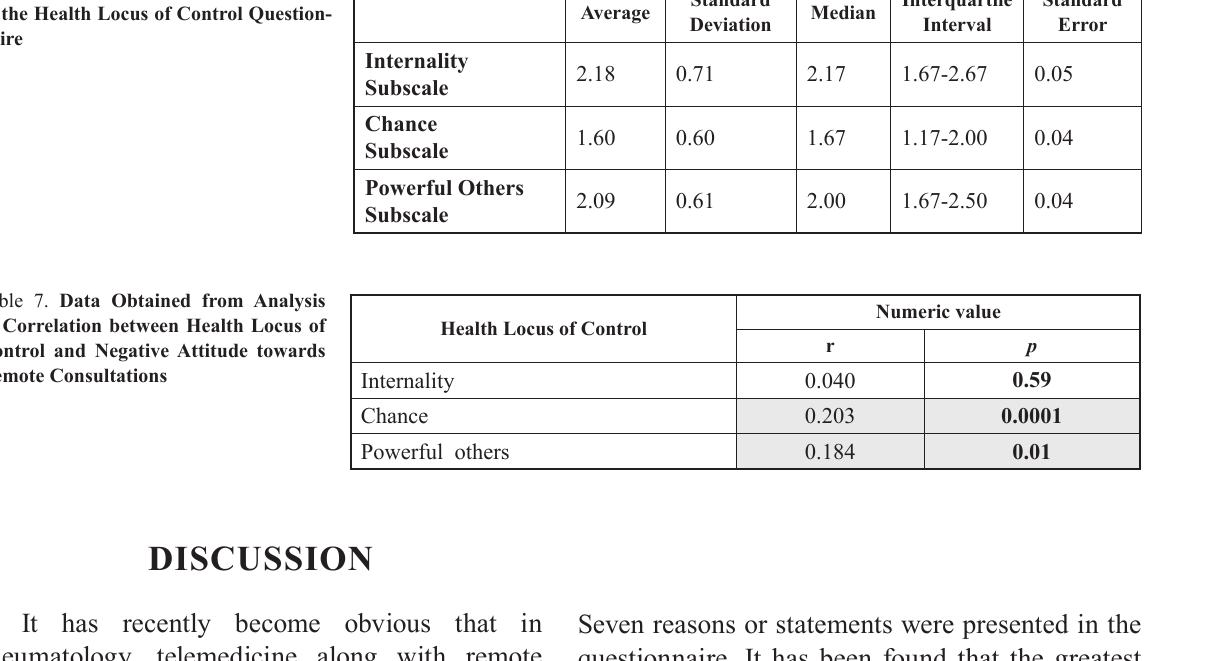
Table 6. Descriptive Statistics of Subscales of the Health Locus of Control Question- naire